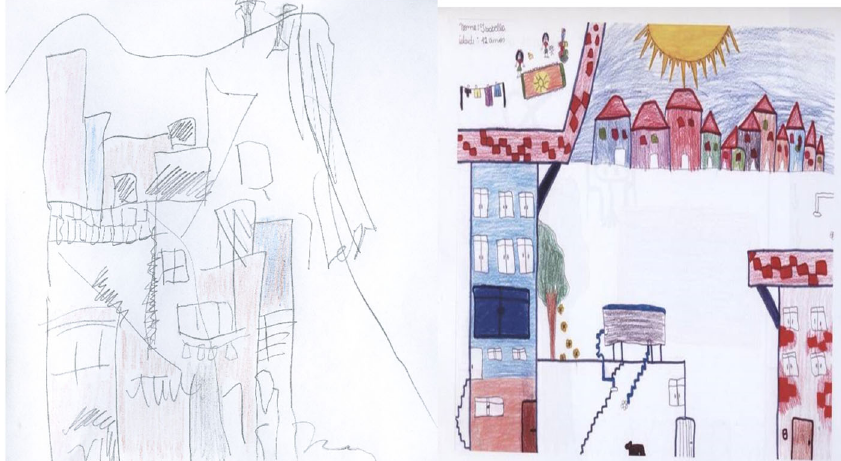
Fig. 3 Drawing of the real house vs. the desired house. F., 12 years old. Example of use of Strategies 1, 2, 4, and 5; increases in architectural details, colors; changes in type of building and pictorial